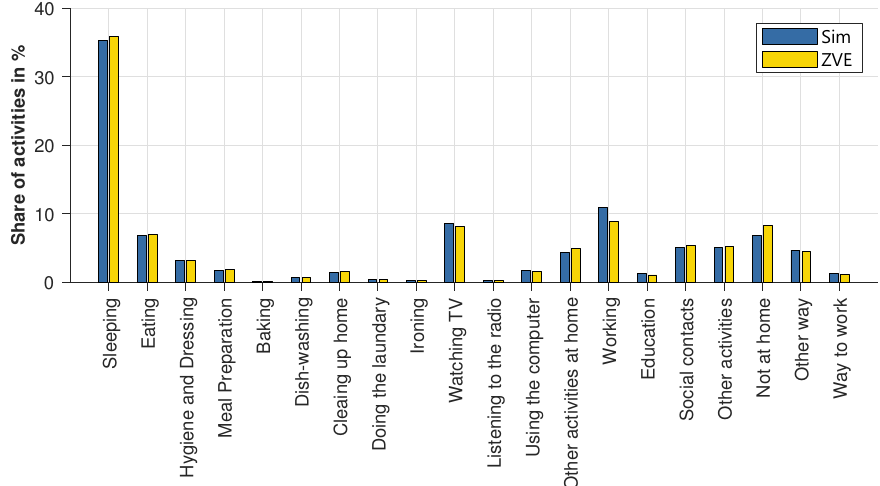
Figure 6. Annual share of activities of the simulation and the ZVE.